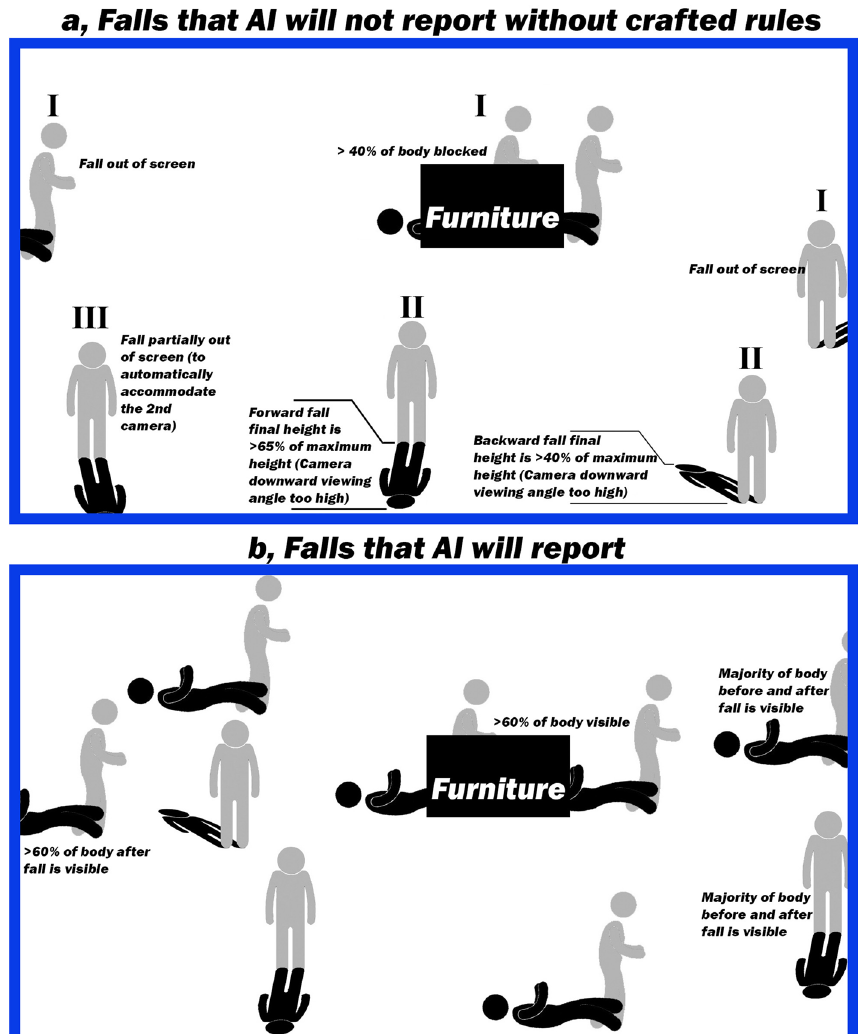
Figure 6. Predefined scenarios of falls the AI will not report without crafted rules and selected examples of falls the system will report. ( a ) Scenario I: When a person or > 40% of a person falls off of the screen, the fall will not be detected, because there is not enough body in the camera view for detection. Scenario II: If the downward viewing angle is greater than 45°, the apparent height after a fall will be longer than 40% of the maximum height during the backward fall, and longer than 65% of the maximum height during the forward fall. These scenarios indicate that the camera angle is not properly adjusted; in this case, we crafted some rules to extend the detectability of the falls. To further enhance detection at steep downward angles which may otherwise have poor accuracy, we measure the fall pattern and inactive time. These crafted rules allow forward fall detection with apparent final heights extending from 65 to 95%, and backward fall detection with apparent final heights extending from 40 to 70%, at steep downward camera viewing angles. Scenario III: When a person touches the predefined boundary (also known as the electronic fence), a part of the fall pattern may not be properly analyzed. The system will need to use the crafted rule of inactive time to maximize detection efficiency. A second camera can also be used at a different location to optimize the coverage and improve the detectablility as demonstrated in Fig. 3. No additional calibration is needed. More crafted rules are explained in “Methods”. ( b ) Selected examples of falls the system reports. When > 60% of the body is visible on the screen and does not touch the predefined boundary (lower edge of the screen) after the fall, it will be